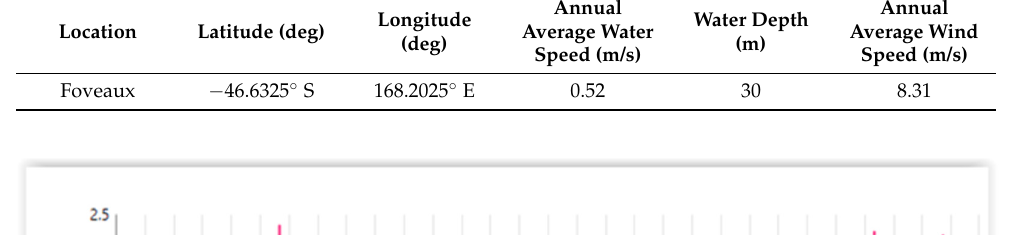
Table 1. The environmental parameters of the Foveaux site.